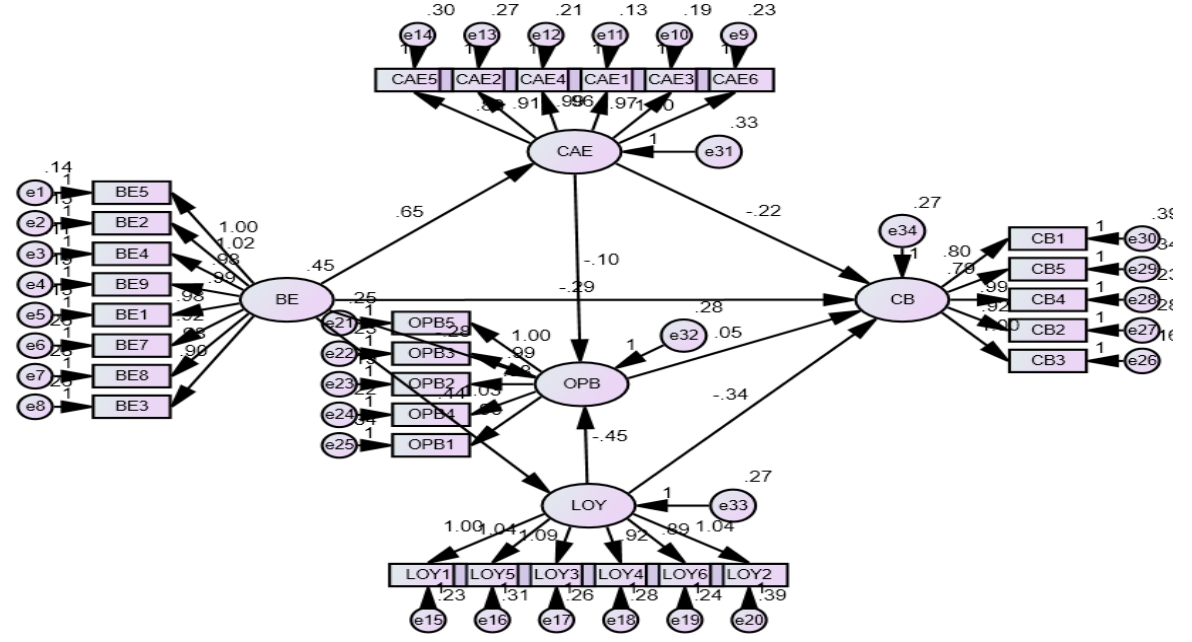
Figure 3. SEM model analysis.